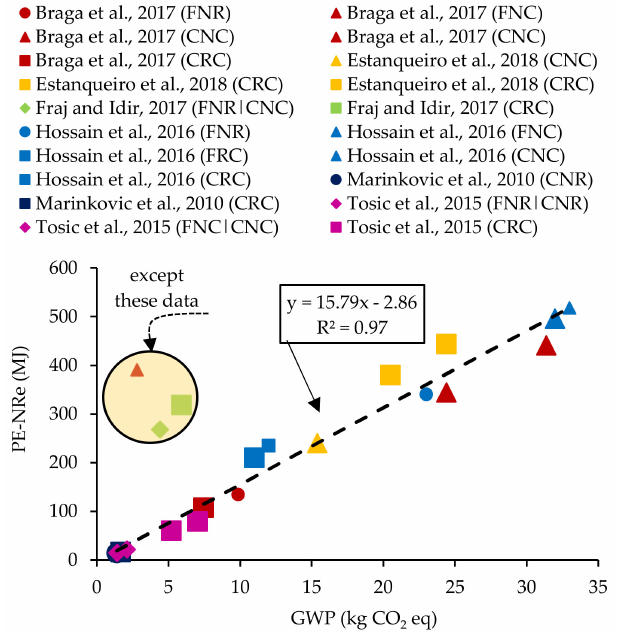
Figure 4. GWP (kg CO 2 eq) vs. PE-NRe (MJ) results from the literature review, per tonne of aggregate.